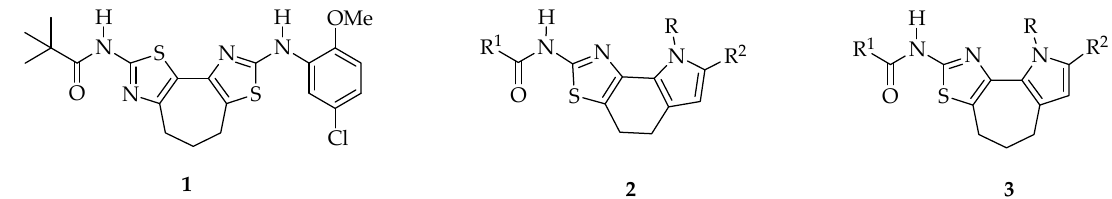
Figure 2. Structure of N -(8-((5-chloro-2-methoxyphenyl)amino)-5,6-dihydro-4 H cyclohepta[1,2- d :3,4- d ′ ] bis(thiazole)-2- yl)pivalamidebithiazole ( 1 ), [1,3]thiazolo[5,4- g ]indole-2-amines ( 2 ) and pyrrolo[3’,2’:6,7]cyclohepta[1,2- d ][1,3]thiazol-2- amines ( 3 ).